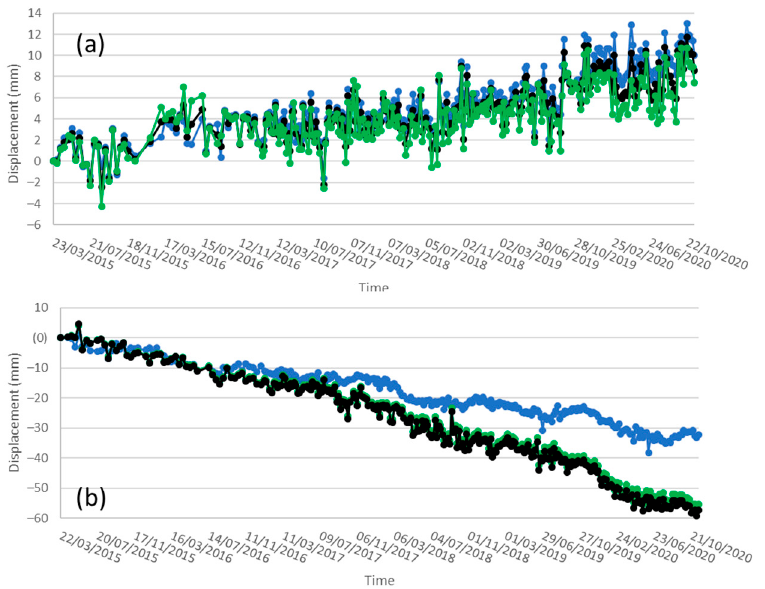
Figure 11. Example of some time series located inside the landslide area: ( a ) ascending dataset; ( b ) descending dataset.